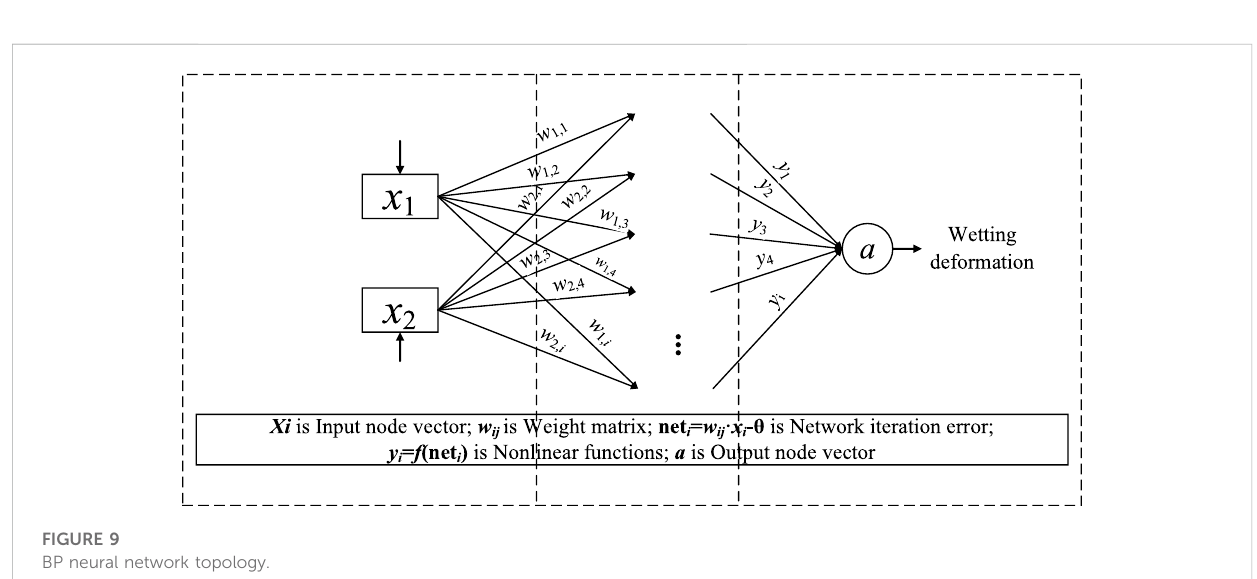
FIGURE 8 Comparison of simulation results and test results of the P-Z wetting Model.